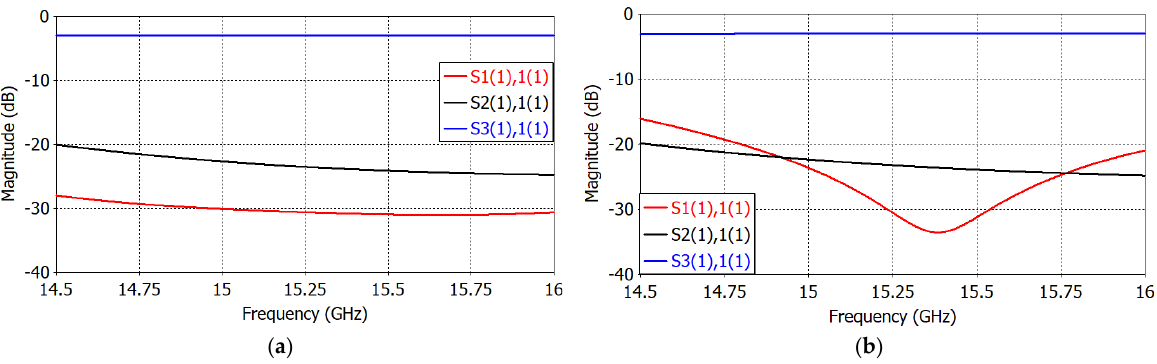
Figure 3. Scattering parameters of the designed polarizer. ( a ) With waveguide mode. ( b ) With coaxial probe.